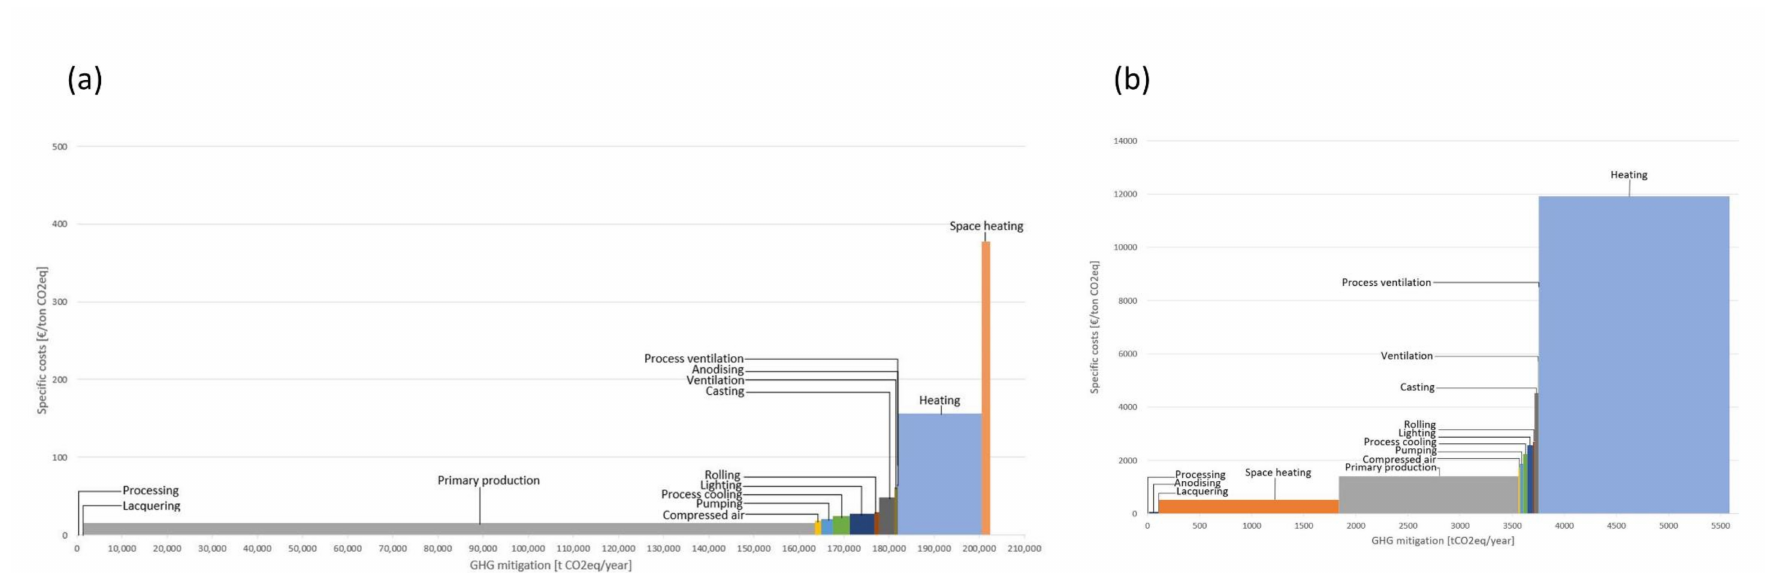
Figure 15. The GHG mitigation potential for the Swedish aluminium industry and two aluminium casting foundries. Figure ( a ) shows the mitigation potential when coal condensing power is assumed to represent the marginal electricity production. Some processes have a small energy saving potential and are therefore difficult to visualise in the abatement curve. These processes are processing (GHG mitigation cost: EUR 0 t CO 2eq ), lacquering (GHG mitigation cost: EUR 3/t CO 2eq ), anodising (GHG mitigation cost: EUR 65/t CO 2eq ) and process ventilation (GHG mitigation cost: EUR 90/t CO 2eq ). Figure ( b ) shows the mitigation potential when hydro power is assumed to represent the marginal electricity production. Some processes have a small energy saving potential and are therefore difficult to visualise in the abatement curve. These processes are processing (GHG mitigation cost: EUR 0/t CO 2eq ), lacquering (GHG mitigation cost: EUR 277/t CO 2eq ), anodising (GHG mitigation cost: EUR 65/t CO 2eq ) and process ventilation (GHG mitigation cost: EUR 8469/t CO 2eq